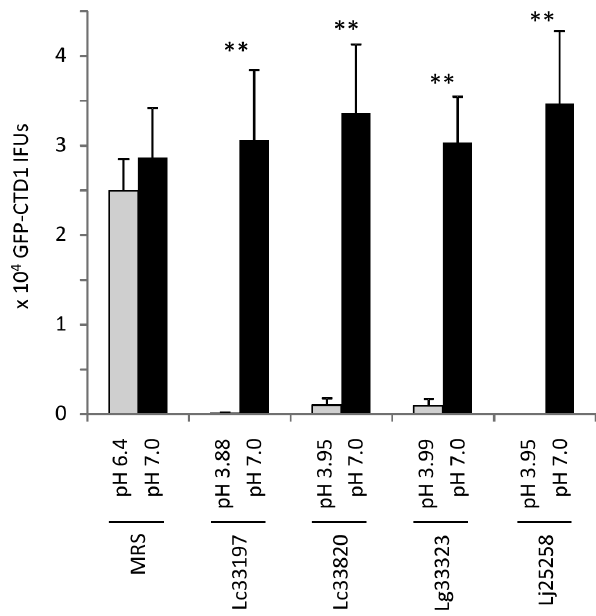
Figure 6. Acid-dependent inactivation of EBs of C.trachomatis serovar D-derived GFP-CTD1 by LCM. Experiments were carried in the same manner as those in Fig. 3 except centrifugation was used to facilitate infection. Values were averages 6 standard deviations of triplicate experiments. Double asterisks indicate statistically significant difference (P , 0.01, respectively) in the numbers of surviving EBs between treatment with LCM and that with neutralized LCM (pH 7.0).